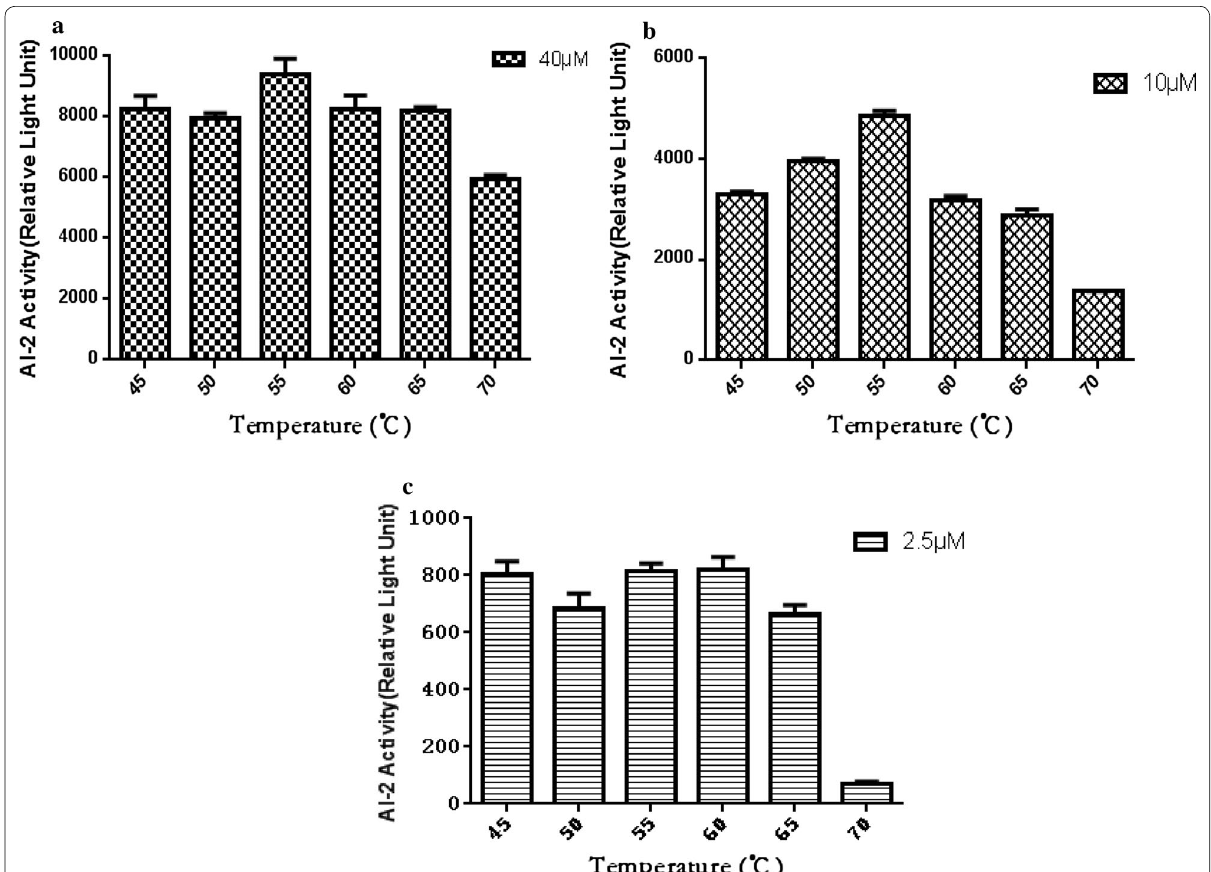
Fig. 3 Thermal stability of AI-2. The different concentrations of AI-2 solution 40.0 μM ( a ), 10.0 μM ( b ) and 2.5 μM ( c ), respectively. Then, the AI-2 solution was incubated for 10 min at 37, 45, 50, 55, 60, 65 or 70 °C, respectively. After a 10-min incubation, the AI-2 solution was filtered through a 0.22-μm filter (EMD Millipore) to obtain cell-free CF for detection of AI-2 activity. AI-2 activity was expressed as relative light units (RLUs). The